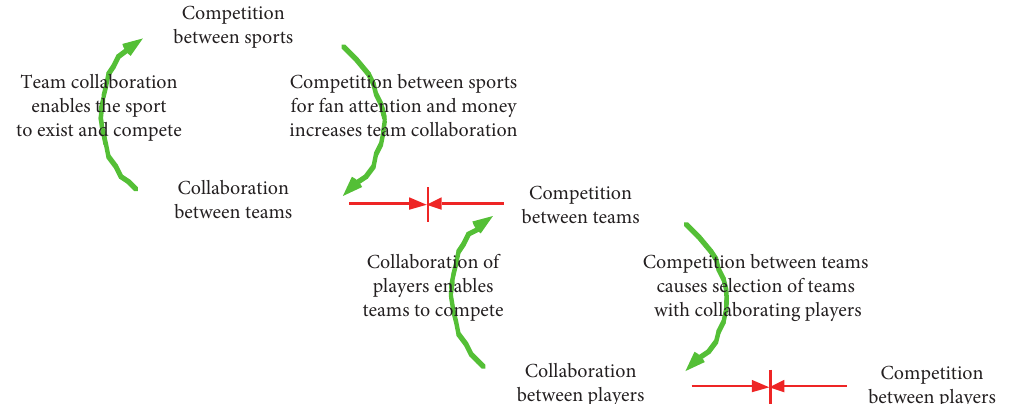
Figure 10: An illustration from Chapter 7 in [16], showing the interplay between cooperation and competition in the context of sports teams and